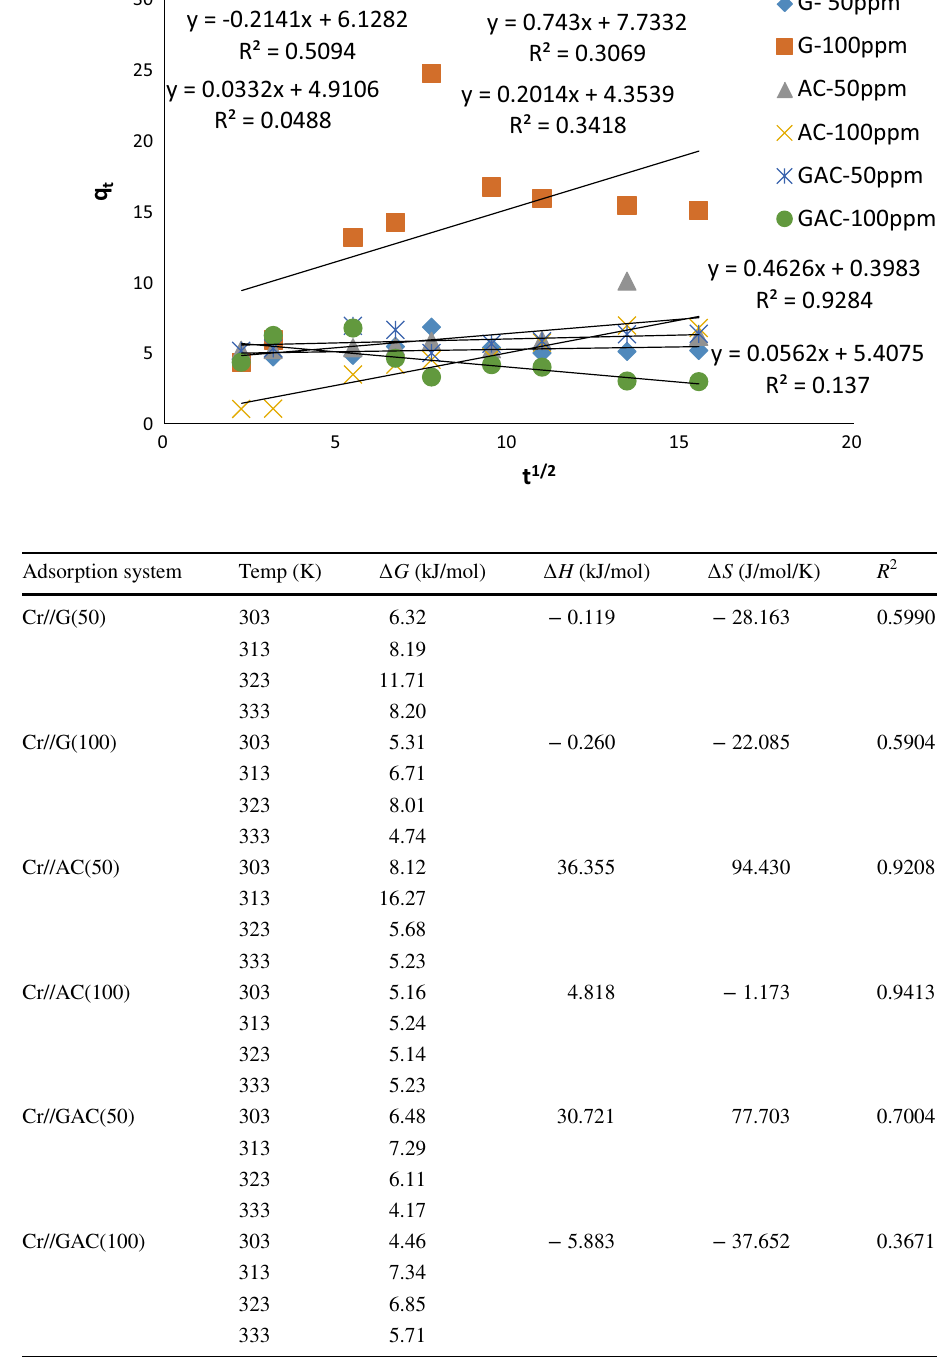
Adsorption system Temp